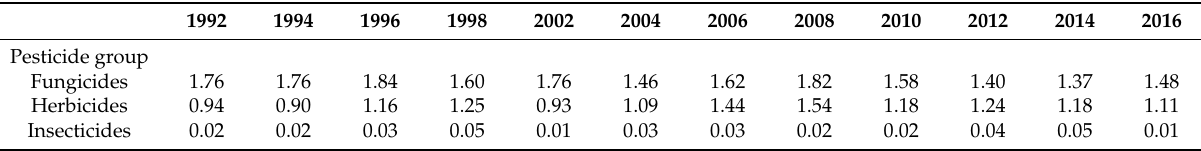
Table 5. Application intensity (kg/ha) for the major pesticide groups applied to arable crops in Northern Ireland 1992–2016.